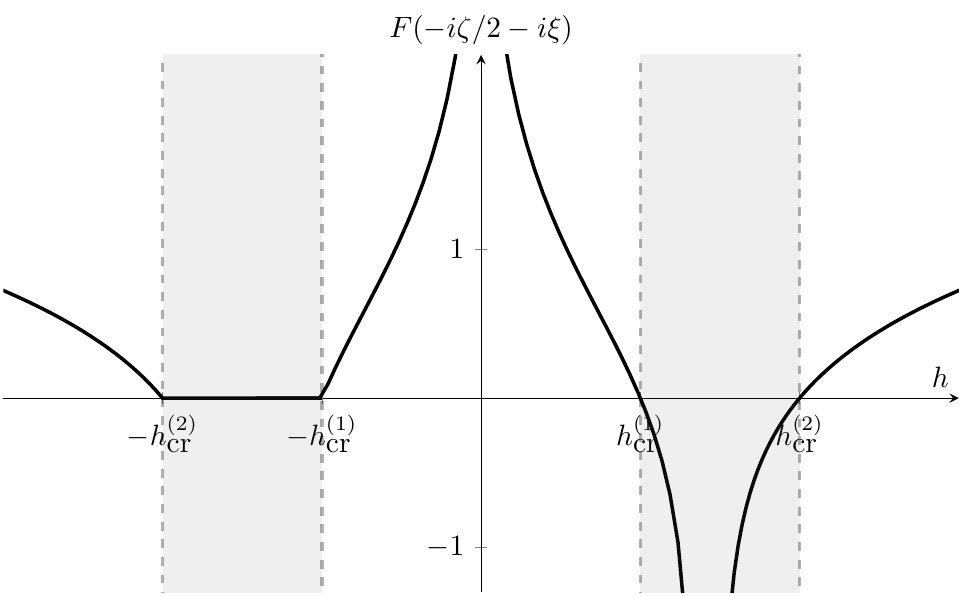
Figure 9: Values of the coefficient F ( − i ζ/ 2 − i ξ ) as a function of the magnetic